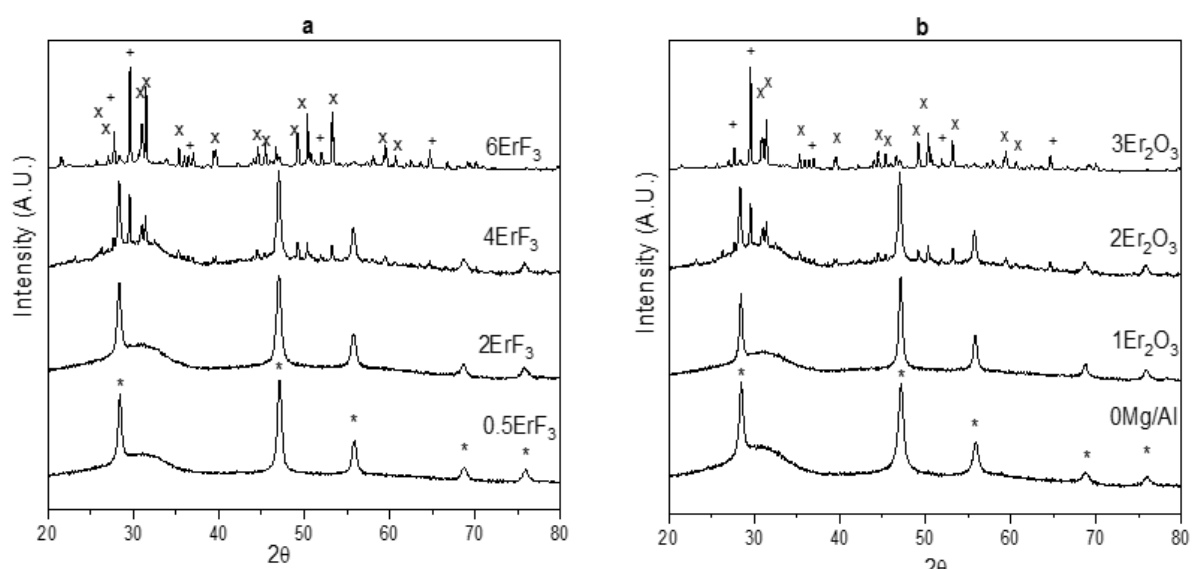
10 Figure 5. Normalized IR spectra of the investigated ErF 3 ( a ) and Er 2 O 3 ( b ) glasses. Note that the 0Mg/Al corresponds to 0.25Er 2 O 3 glass.